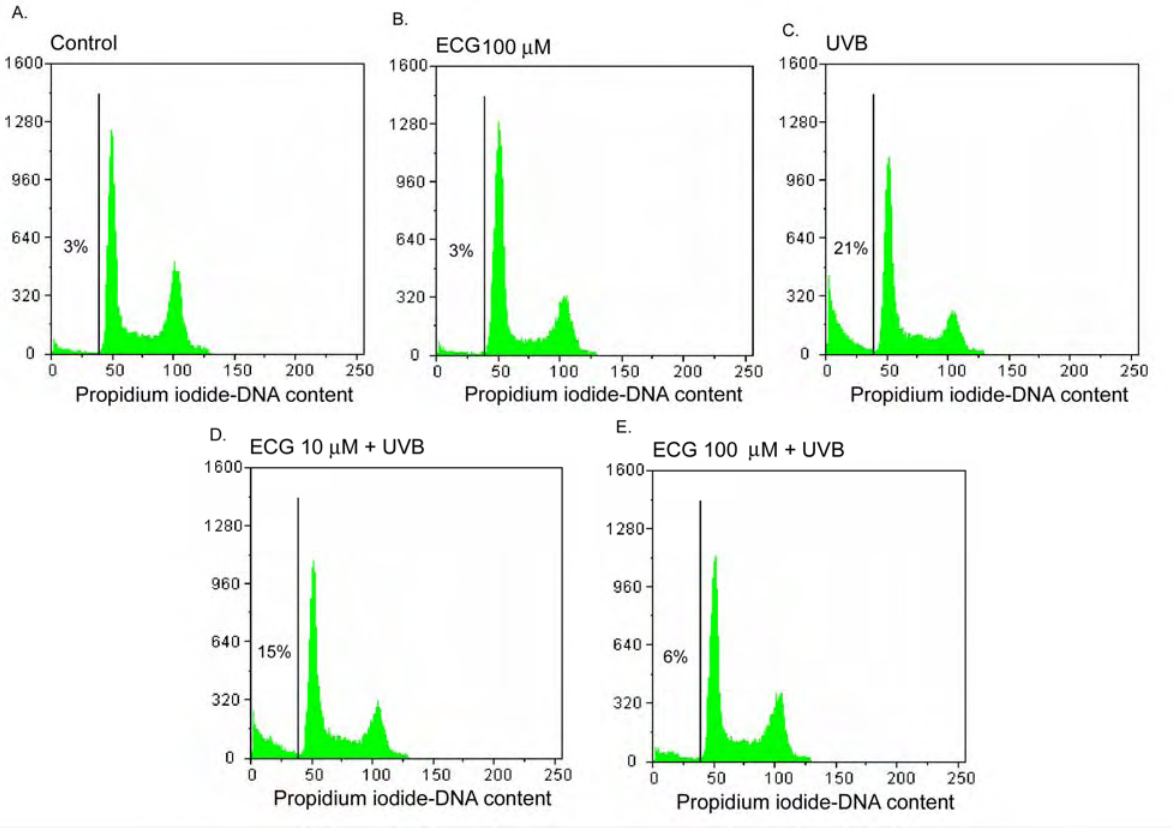
Figure 6. Effect of ECG on UVB-induced changes in DNA content in